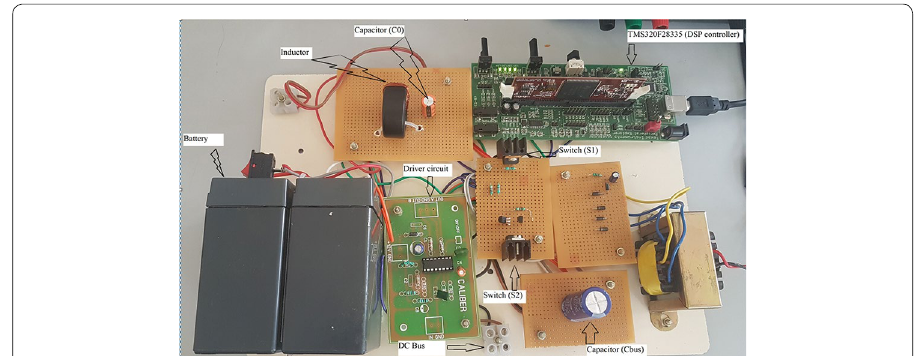
Fig. 7 Hardware of DSP-based closed-loop control of bidirectional buck–boost converter